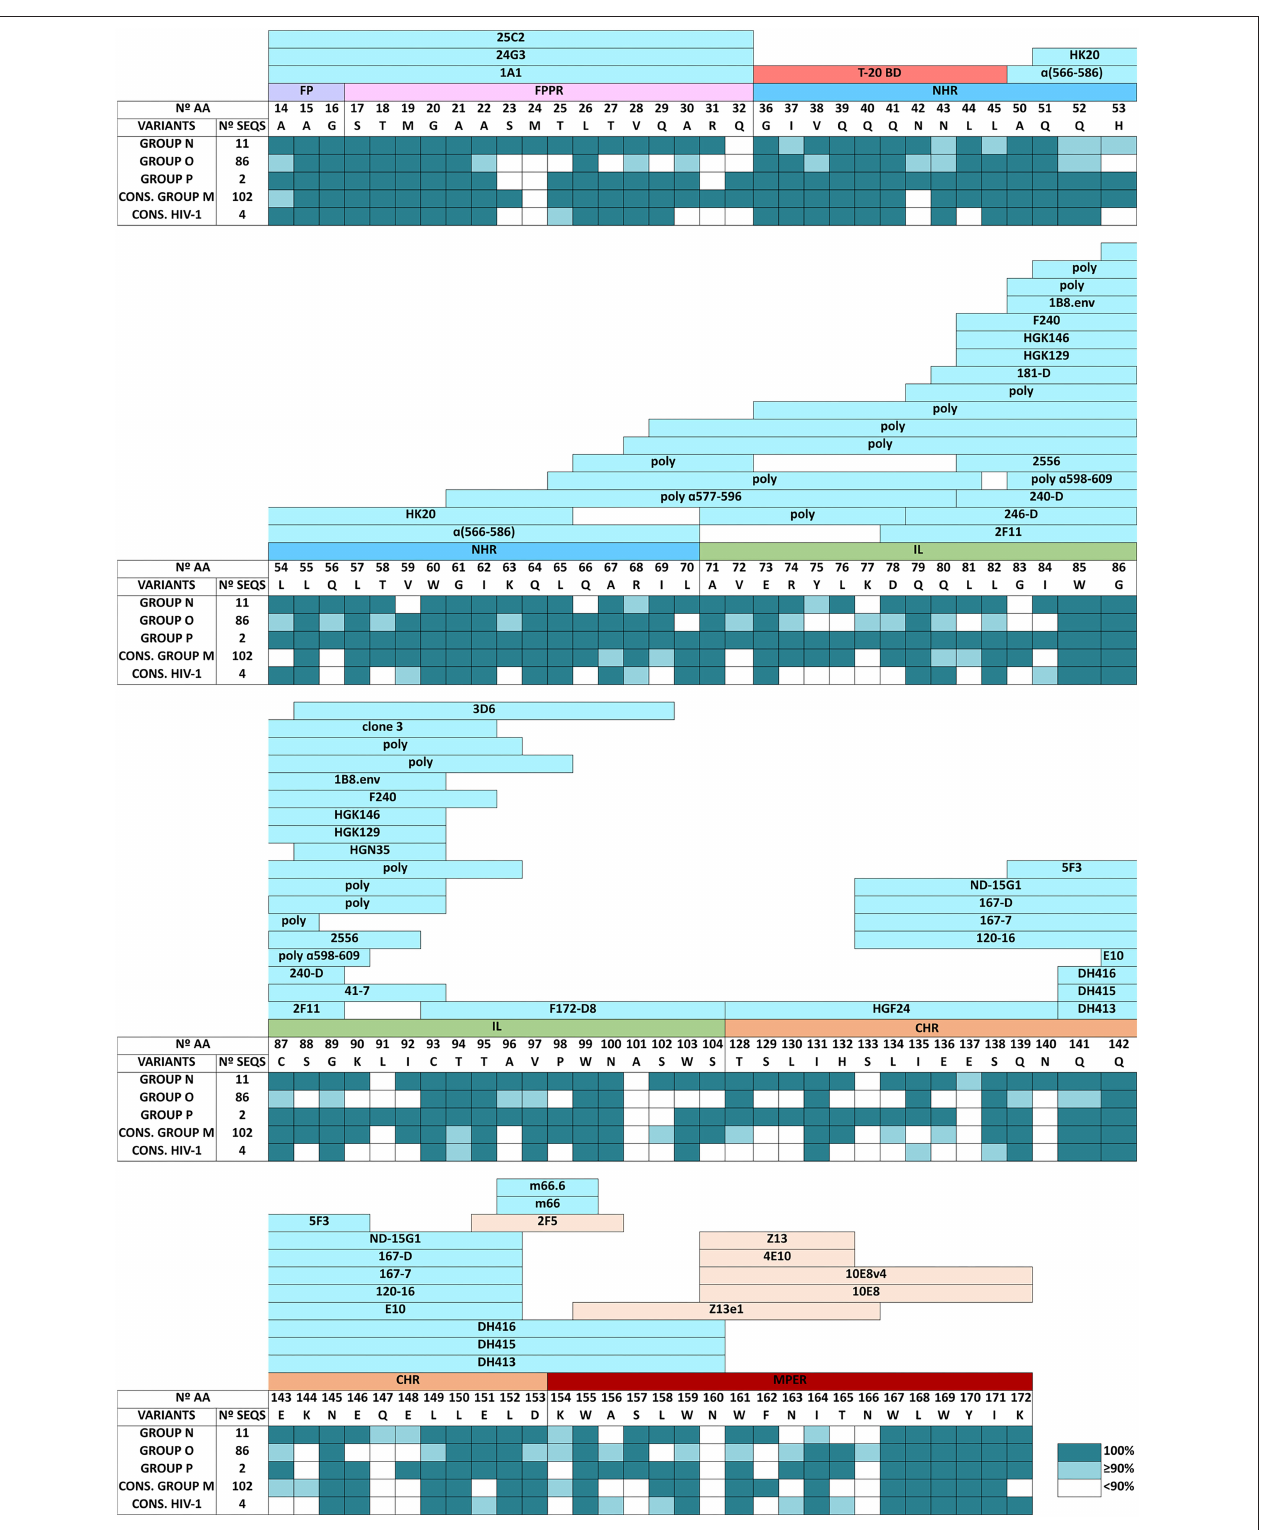
FIGURE 3 | Amino acid conservation level in gp41 residues involved in anti-gp41 human antibody binding domains described in LANL HIV Immunology Database across HIV-1 groups and HIV-1 consensus sequences. Data showed the percentage of the most conserved aa with the following conservation color code: white